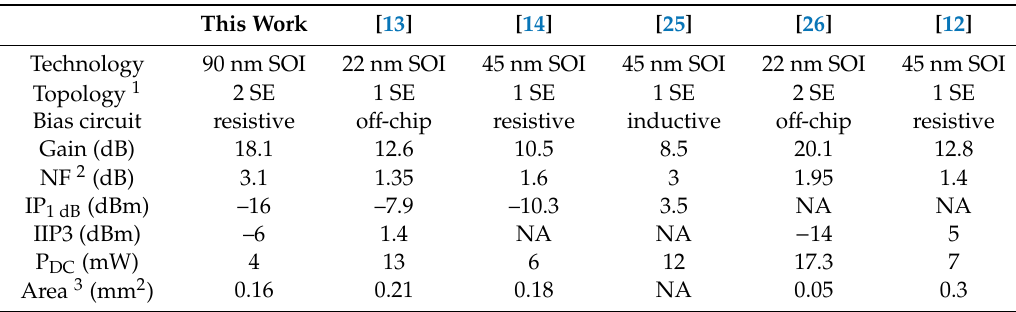
Table 2. Performance comparison table.